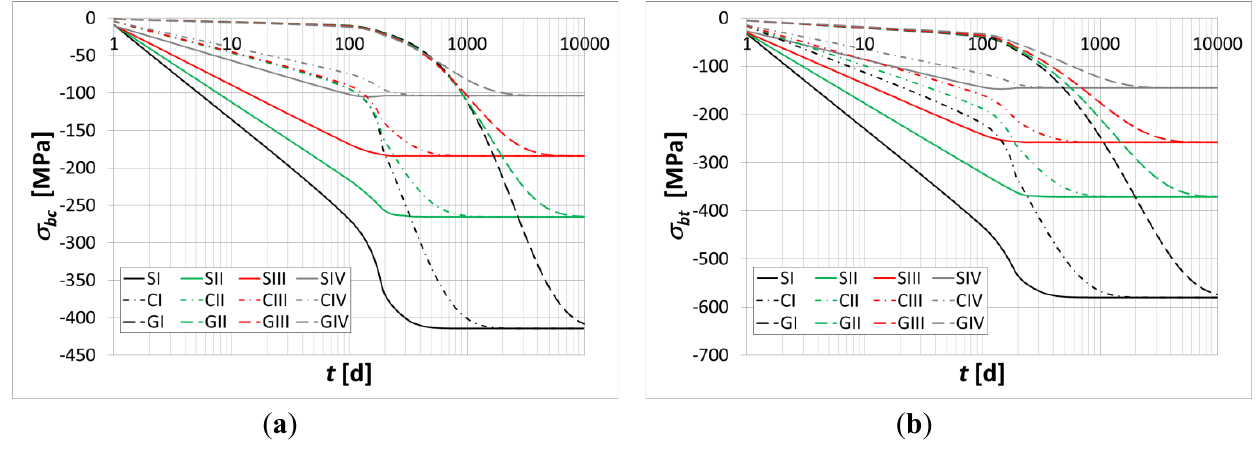
Figure 6. ( a ) Instantaneous stresses in the top reinforcement bars; ( b ) Instantaneous stresses in the bottom reinforcement bars.